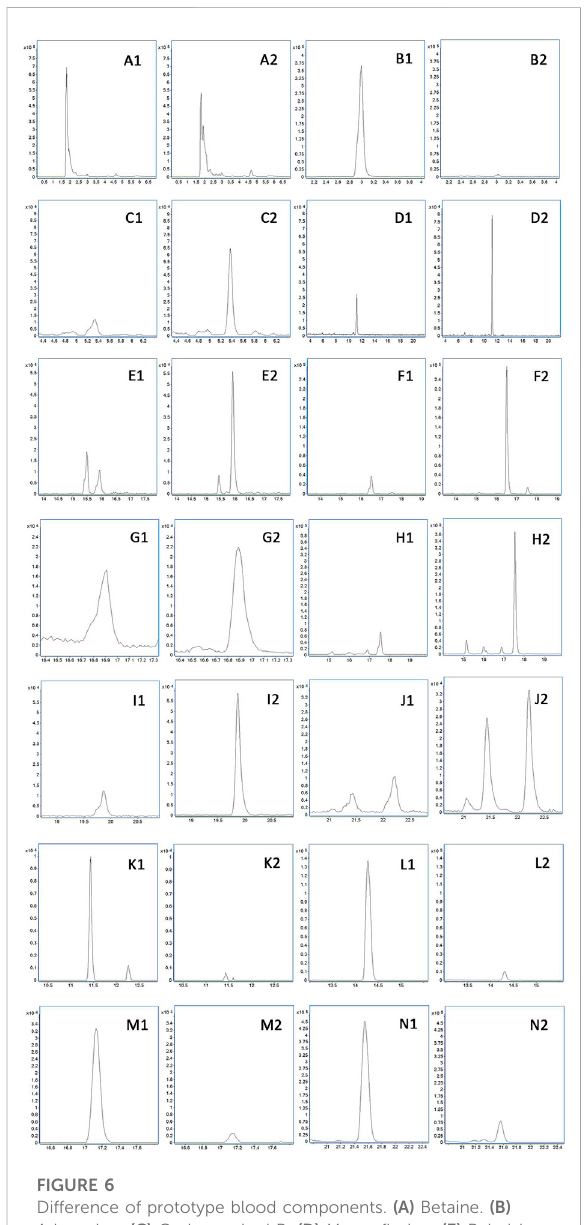
FIGURE 6 Difference of prototype blood components. (A) Betaine. (B) Adenosine. (C) Codonopsinol B. (D) Magno fl orine. (E) Peimisine. (F) Peimine. (G) Zhebeinone. (H) Peiminine. (I) Zhebeinine. (J) Ebeiedinone and Zhebeirine. (K) Vanillin. (L) Hesperetin. (M) Wogonin. (N) Magnolol. 1 presents the physiological state, and 2 presents the pathological